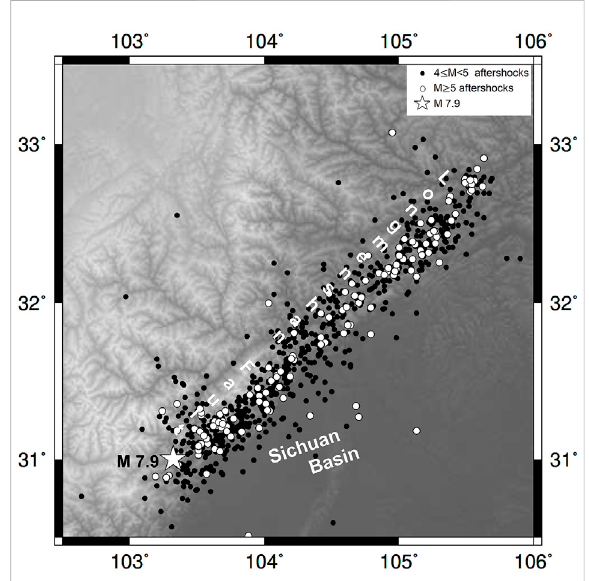
FIGURE 1 Location of the 12 May 2008 Mw 7.9 Sichuan earthquake (white color star) and M ≥ 5 earthquakes (white fi lled dots), and 4 ≤ Mw < 5 (black fi lled dots) till May 2010.